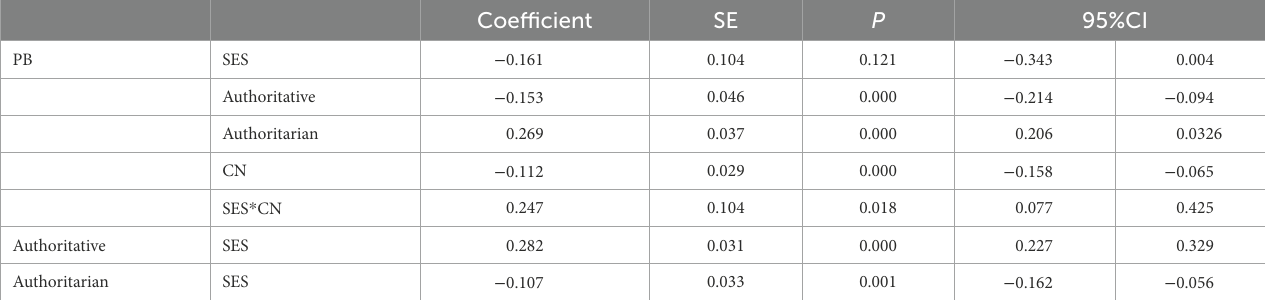
TABLE 3 Structural coefficients of the final model.